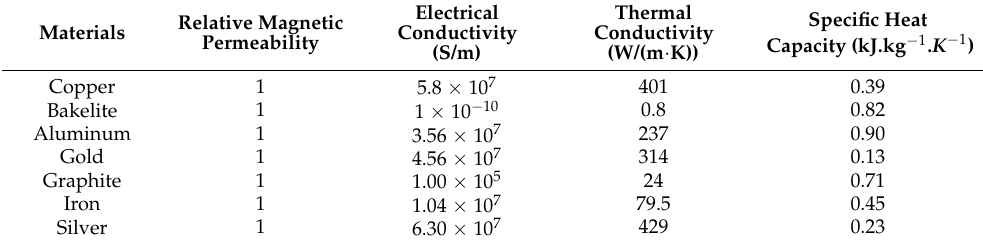
Table 2. Material parameters.